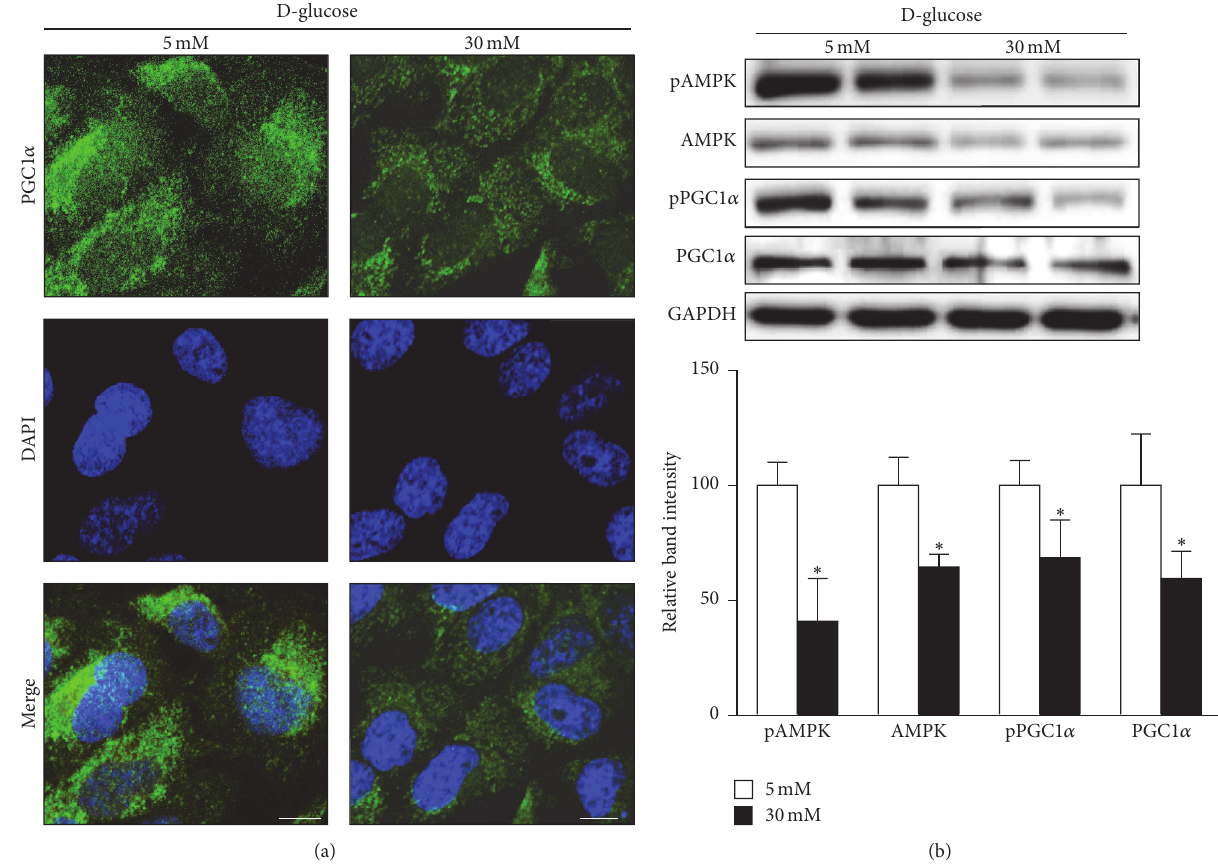
Figure 1: PGC1 𝛼 and AMPK expression in human renal proximal tubular cells (RPTCs) under high-glucose conditions. (a) Representative confocal fluorescence images of PGC1 𝛼 indicate that high-glucose conditions suppress PGC1 𝛼 expression in human RPTCs. (b) Western blot analyses reveal downregulation of PGC1 𝛼 and AMPK under high-glucose conditions ( ∗ 𝑝 < 0.05 compared with the 5 mM glucose condition, scale bar 10 𝜇